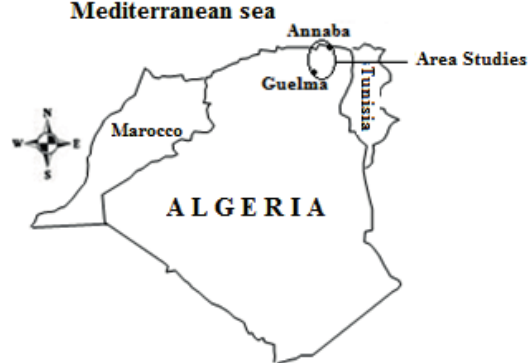
Fig. 1 Geographic location of the studied